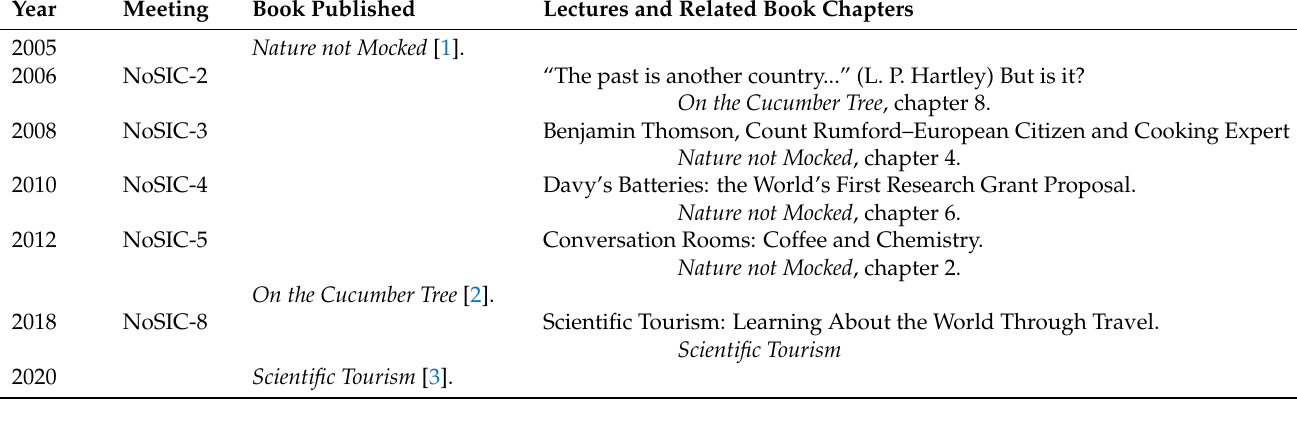
Table 1. Titles and dates of some books published, and lectures given, at the NoSIC meetings in Prullans, by Peter Day, pointing to chapters of his books related to the contents of the talks.